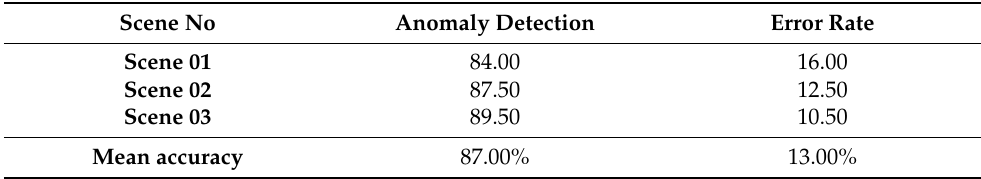
Table 4. Confusion matrix of proposed EPB method over avenue dataset.